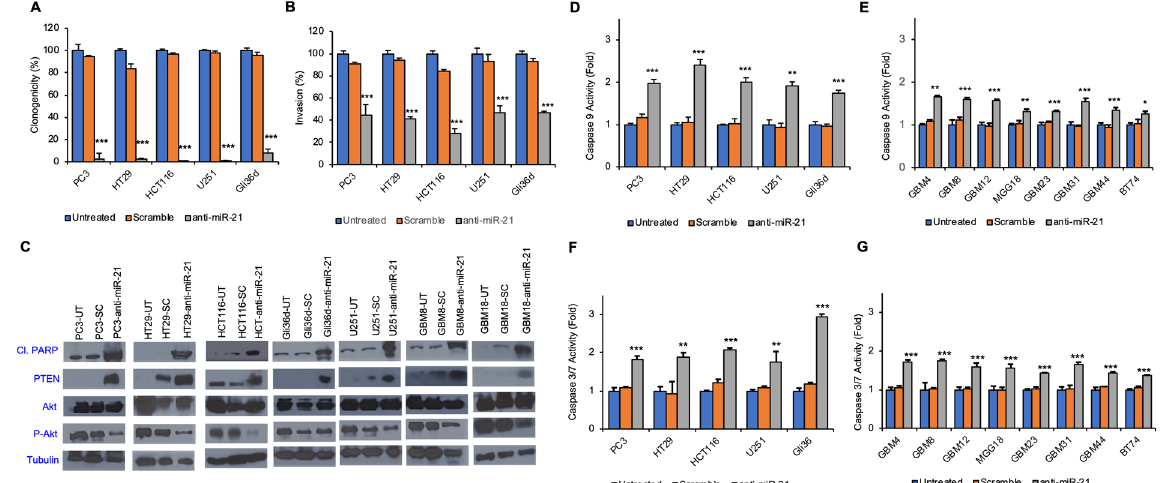
Figure 2. miRzip-21 results in reduced cell clonogenicity and invasion in cancer cell lines. ( A ) Plot showing changes in clonogenicity of various cancer cells following treatment with miRzip-21. ( B ) Plot showing changes in invasion of various cancer cells following treatment with miRzip-21 ( C ) Western blot analysis showing the effect of miRzip-21 in various cancer lines. ( D,E ) Plots showing changes in caspase 9 activity following treatment with miRzip-21 in various cancer cell types. ( F,G ) Plots showing changes in caspase 3/7 activity following treatment with miRzip-21 in various cancer cells. Data are shown as mean ± SD. *** (P < 0.001), ** (P < 0.01) and * (P < 0.05) indicate statistical differences between miRzip-21 infected group and their relevant